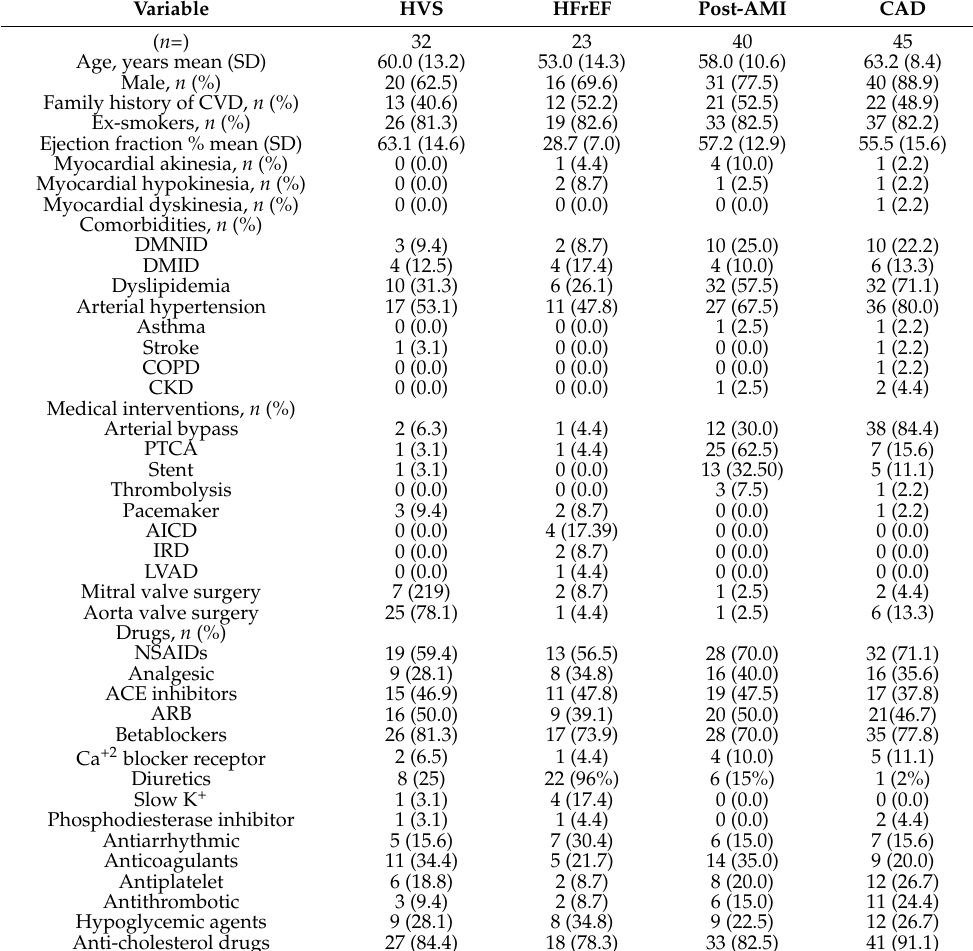
Table 1. Demographic and clinical characteristics of participants by